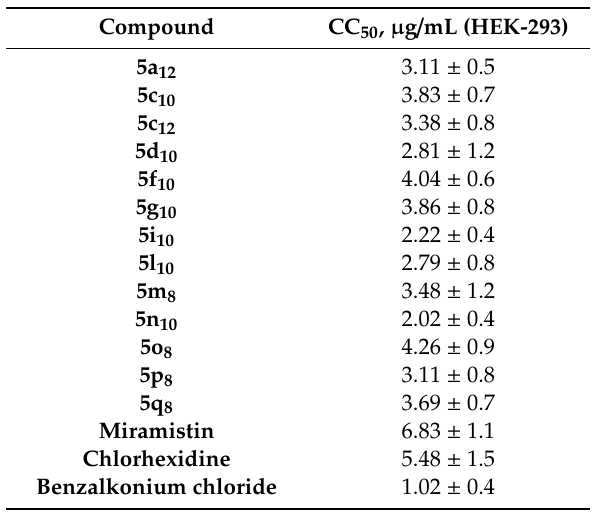
Table 4. Cytotoxicity of novel bis-ammonium salts of